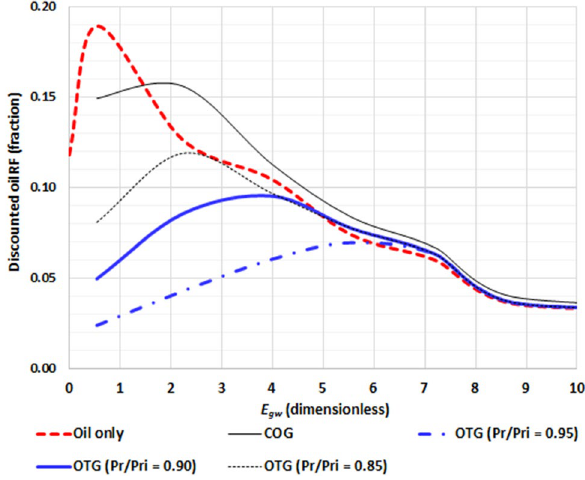
Fig. 5 Discounted oil RF versus E zontal oil producers. Note that E gw = 0 refers to the undersaturated